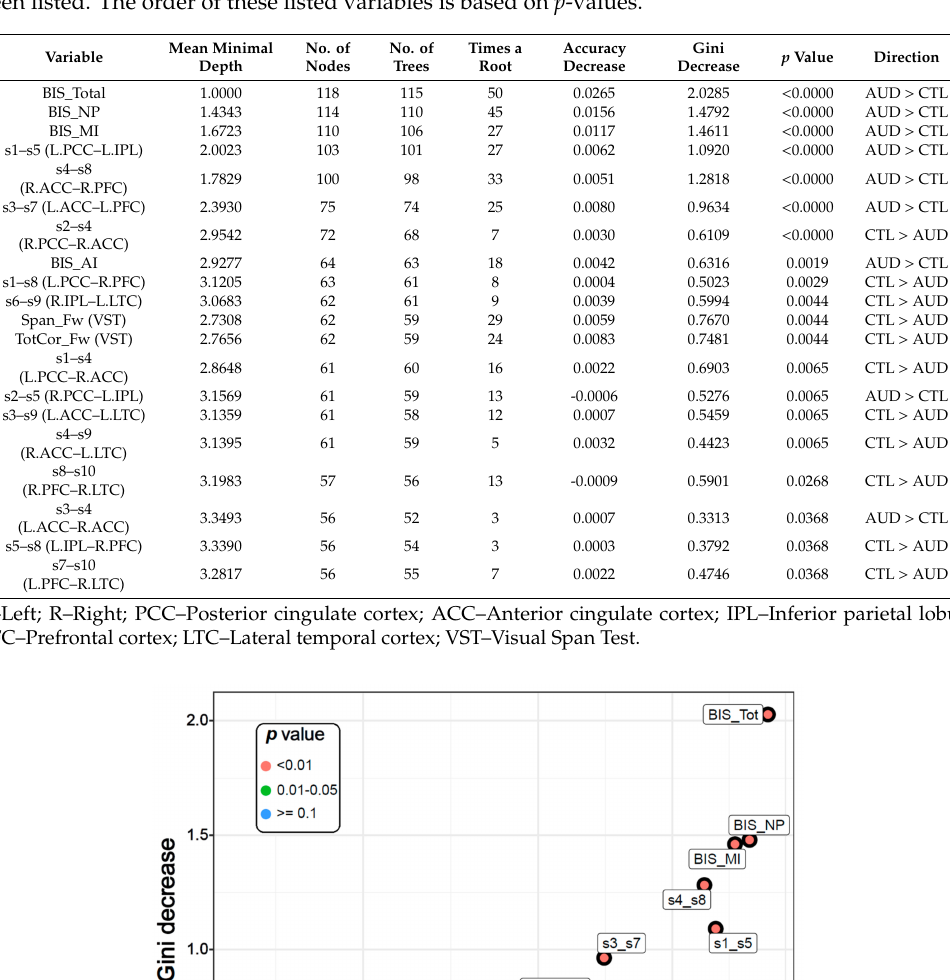
Table 3. Random Forest (RF) importance parameters (mean minimal depth, number of nodes, number of trees, times a root, accuracy decrease, Gini decrease, and p -value) and the direction of significance for the top significant variables ( p < 0.05) are shown. All significant variables that were important to classify individuals into either the alcohol use disorder (AUD) group or the control (CTL) group have been listed. The order of these listed variables is based on p -values.